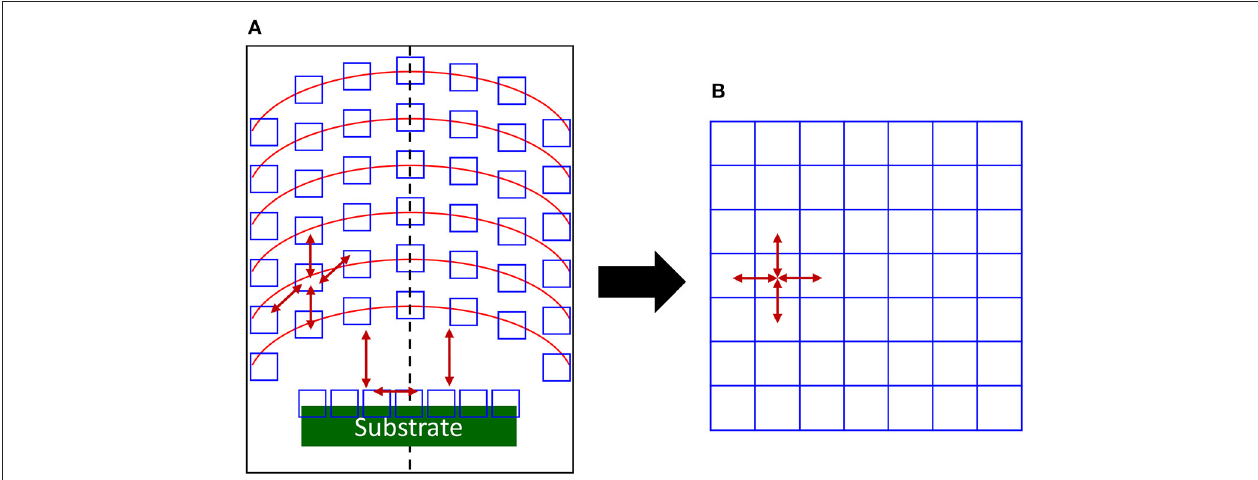
FIGURE 1 | 2D schematics of the mapping of (A) a plasma reactor illustrating gradients at different reactor heights (red lines). Relevant experimental cells are open blue squares and arrows indicates species exchange between cells. The specific region of the substrate is green with its own cells interacting with the plasma phase. The dashed line is displaying the symmetry axis in this case and (B) to the corresponding full simulation box with communicating primary simulation boxes. Arrows gives the possible communications between the cells for covering all the experimental situations. Only a few are present for clarity.